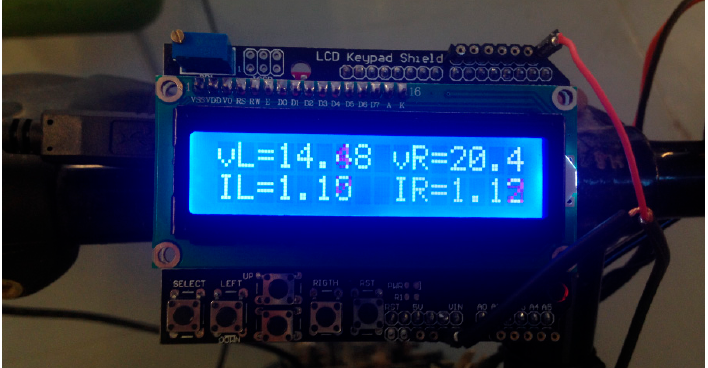
Figure 7. Display for the visualization of the instantaneous values of the variables of the vehicle under study to be used by the LEV driver.